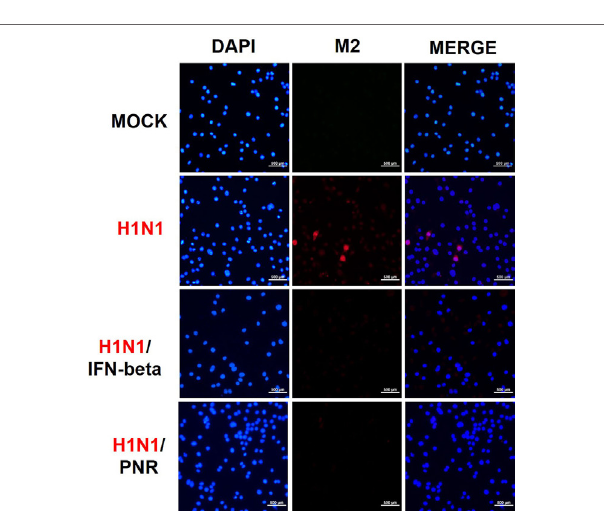
FigUre 6 | Panax notoginseng root (PNR) reduced the expression of the M2 protein of influenza A/PR/8/34 (H1N1) virus in infected RAW 264.7 cells. Immunofluorescence analysis illustrated the level of influenza A M2 protein in RAW 264.7 cells. Cells were treated with PNR (100 µg/mL) or interferon (IFN)- β (1,000 U/mL) after influenza A virus infection. An influenza A virus M2-specific antibody was used to observe the protein in RAW 264.7 cells via fluorescence microscopy. Cells were also stained with DAPI, and the merged image shows the cytoplasmic location of M2